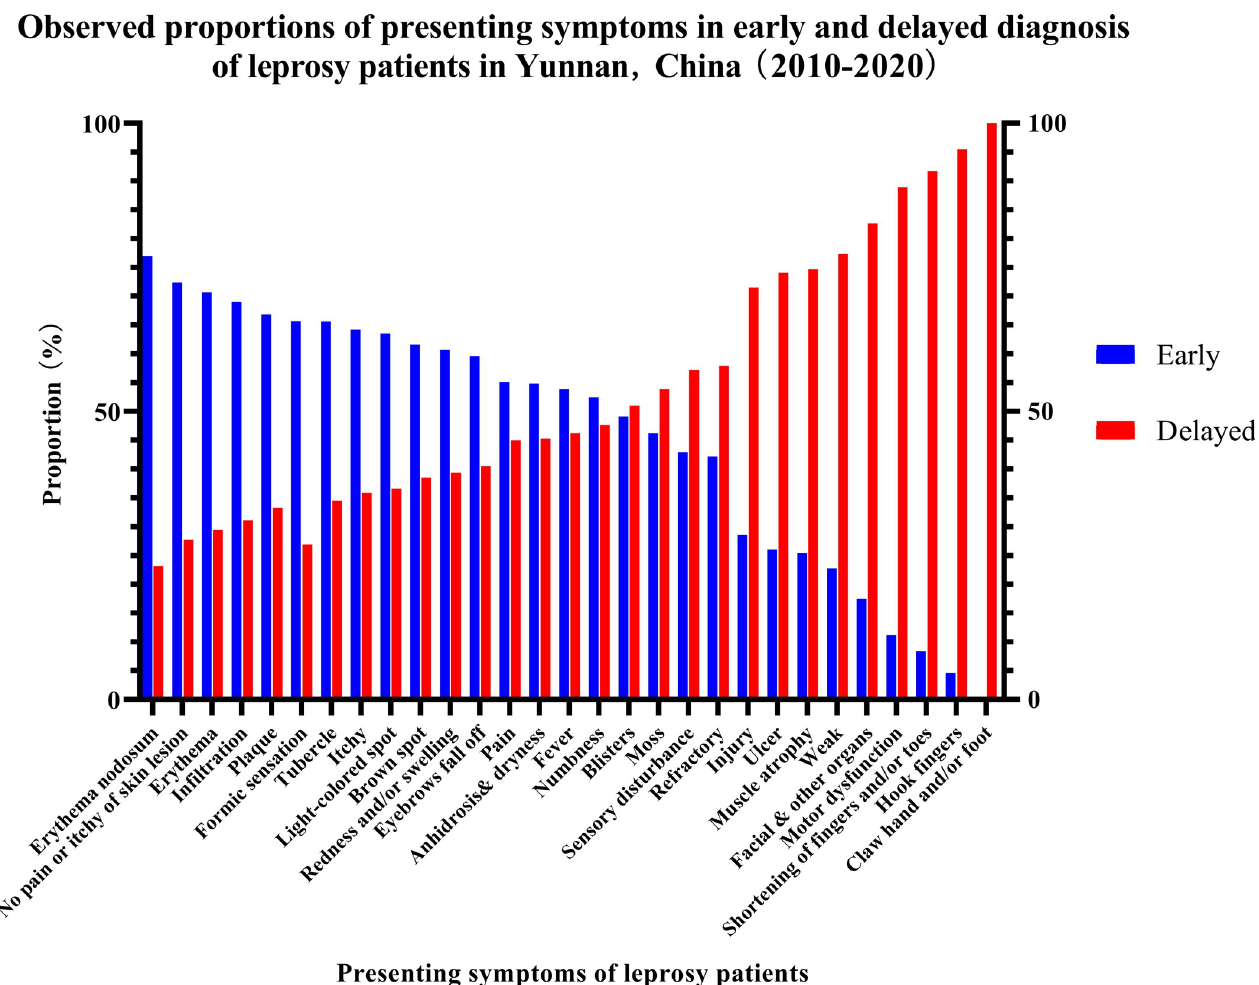
Fig 3. Observed Proportions of Presenting Symptoms in Leprosy Patients with Early and Delayed Diagnosis. the fingers and toes (11/12, 91.67%), claw hands and/or foot deformity (5/5, 100.00%), and facial features (19/23, 82.61%), mainly occurred in the delayed diagnosis group (Table 5). The odds ratios of symptoms in the early diagnosis group are shown in S2 Table. Initial symptoms at symptom onset and only symptoms at diagnosis A total of 2069 and 2125 newly detected leprosy patients were included in the analyses of initial symptoms and only symptoms related to physical disability and diagnosis interval, respec- tively. The initial symptoms at symptom onset and the only symptoms at diagnosis were divided into skin, skin and nerve, and nerve symptoms (Table 6). The proportions of skin, skin and nerve, and nerve symptoms as initial symptoms were 33.25%, 44.95%, and 21.80% and as only symptoms were 28.66%, 57.81%, and 13.53%, respectively. Regarding initial symp- toms, the proportions of patients with physical disability (G1D + G2D) were 28.92%, 30.32% and 57.65% for skin, skin and nerve, and nerve symptoms, respectively. Regarding only symp- toms, the proportions were 25.97%, 33.78% and 65.36%, respectively. Similarly, regarding